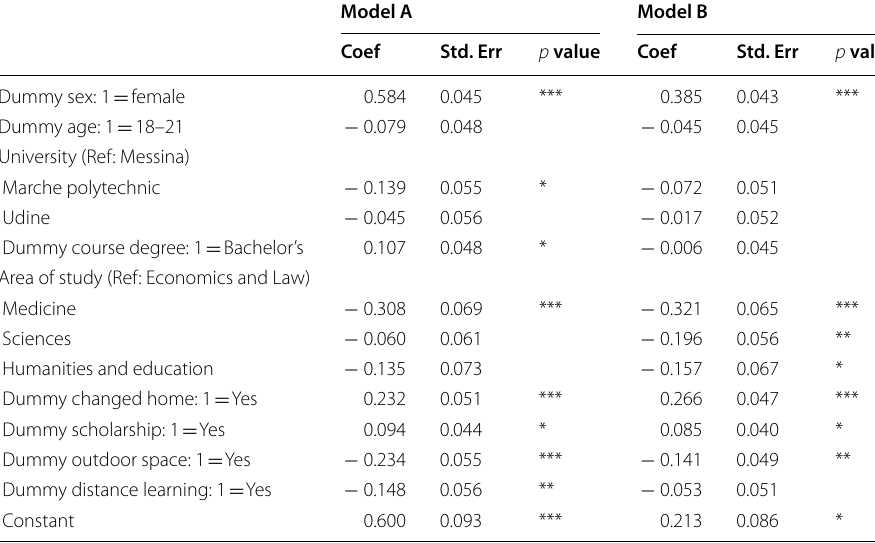
Table 7 Estimation results of the Probit models